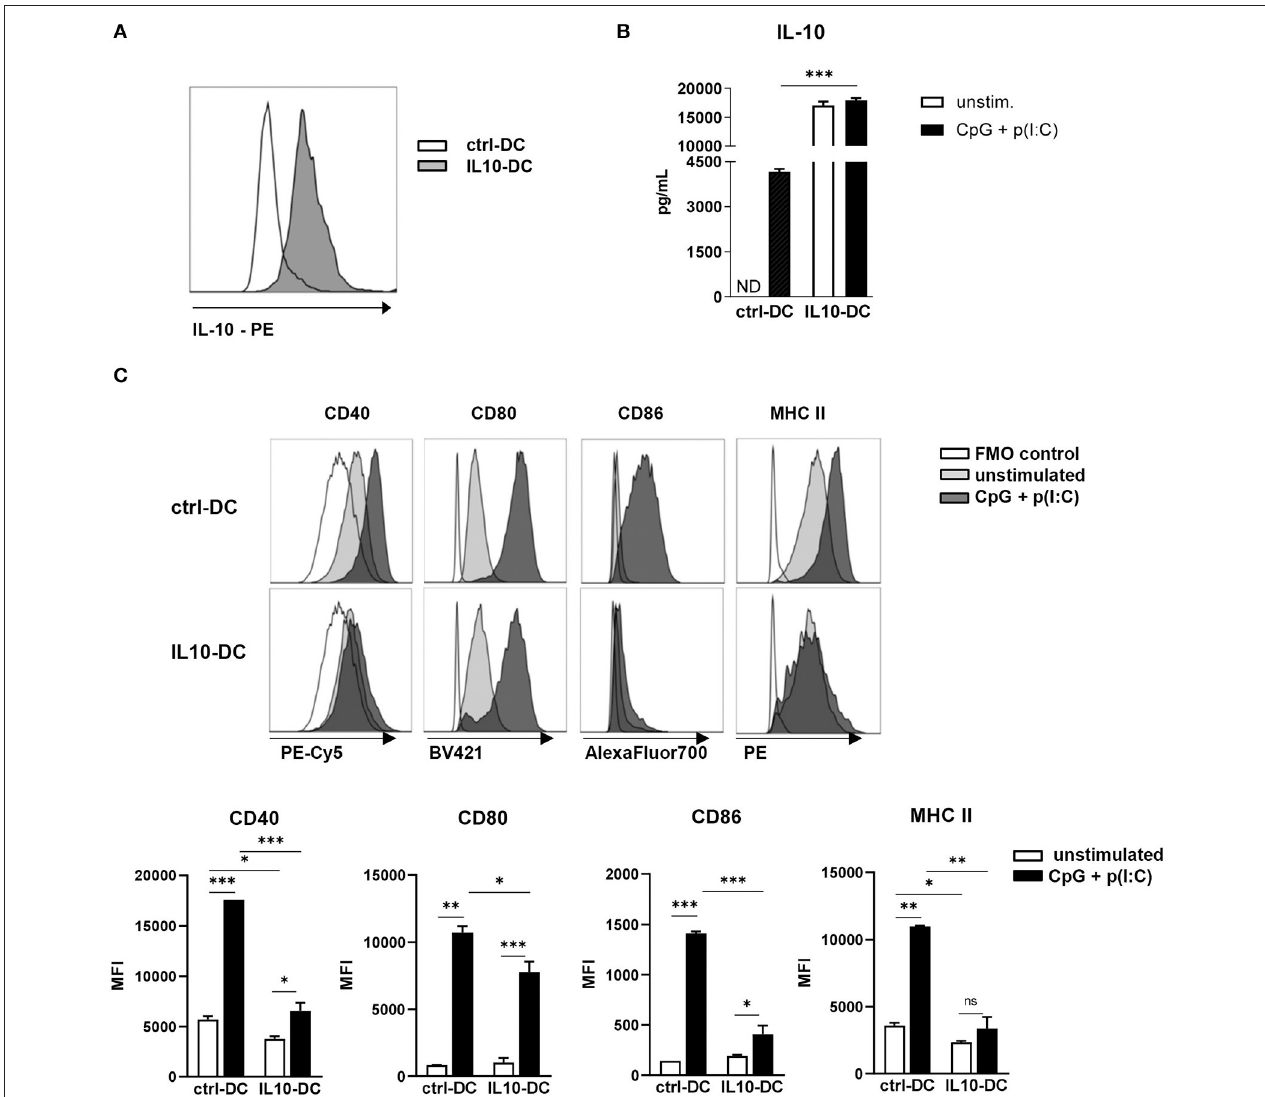
FIGURE 1 | Characterization of the novel IL-10-expressing DC line. 2.5 × 10 5 control MutuDCs or IL10-DCs or were stimulated with CpG (1 µ M) + Poly I:C (5 µ g/mL) for 24h. (A) IL-10 expression of control MutuDC (ctrl-DC) and IL10-DC in resting conditions. (B) IL-10 secretion assessed in the supernatants of cells cultures. (C) Flow cytometric analysis of CD40, CD80, CD86, and MHCII surface expression of ctrl-DC or IL10-DC. Data are expressed in Median Fluorescence Intensity (MFI) of GFP + -gated cells. Data are representative of at least three independent experiments. ND, not detected. * P < 0.05; ** P < 0.005, *** P <